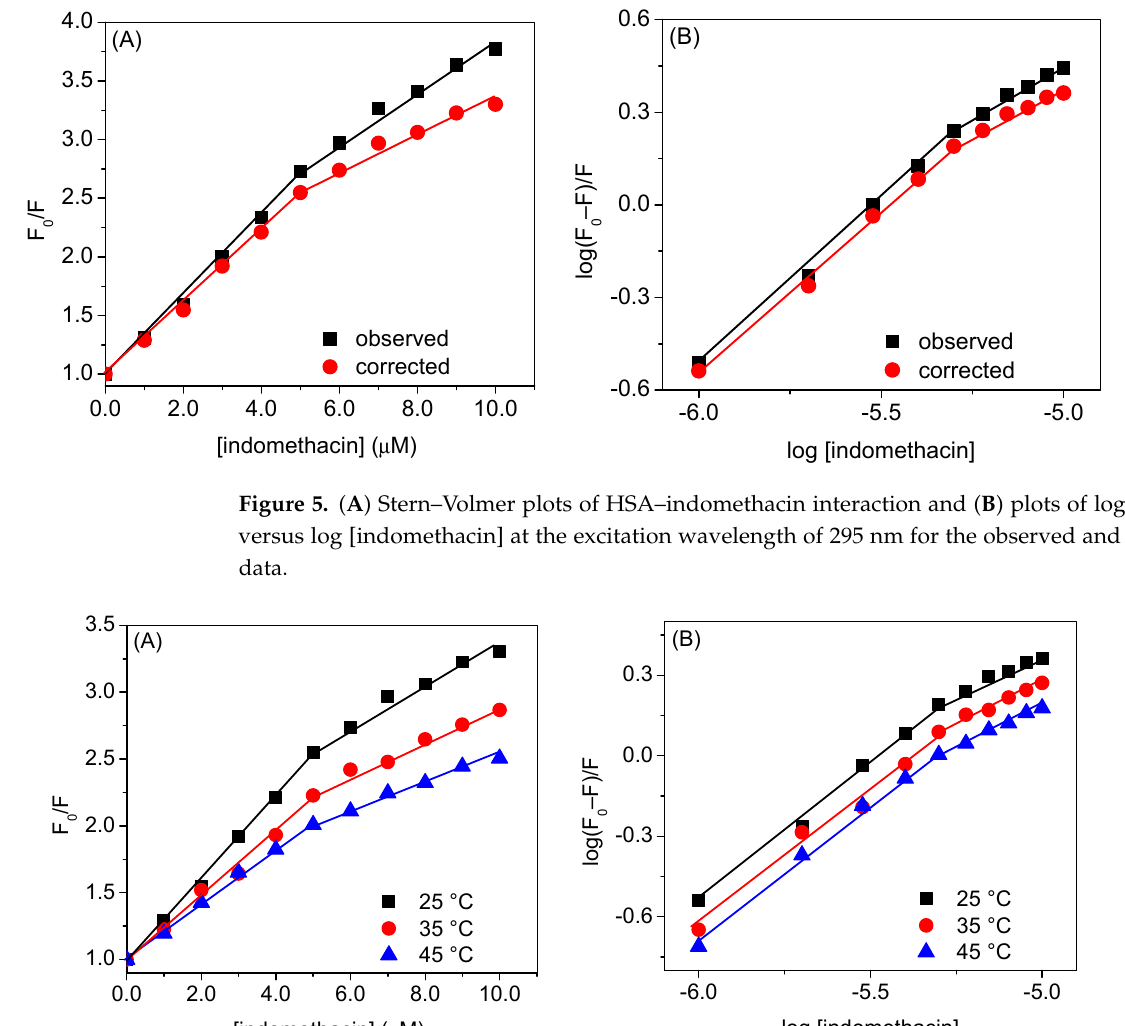
Figure 4. Corrected fl uorescence spectra of HSA in the absence and presence of indomethacin at λ ex of 280 nm ( A ) and 295 nm ( B ) at 25 °C. [HSA] = 3 µM and [indomethacin] = 0. 1.0, 2.0, 3.0, 4.0, 5.0,